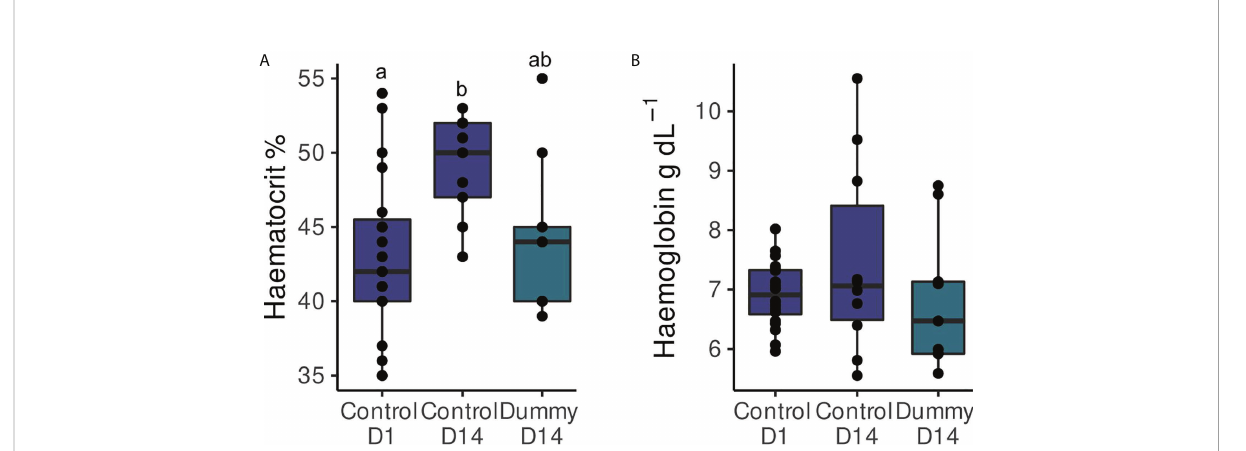
FIGURE 4 Hematologic indicators (mean ± SEM). (A) Hematocrit and (B) hemoglobin concentrations of the control group on the 1st day (08 March 2021) and the control (N=25 fi sh) and dummy (N=20 fi sh) two weeks later (21 March 2021). Different letters indicate statistically signi fi cant differences between the groups (P<